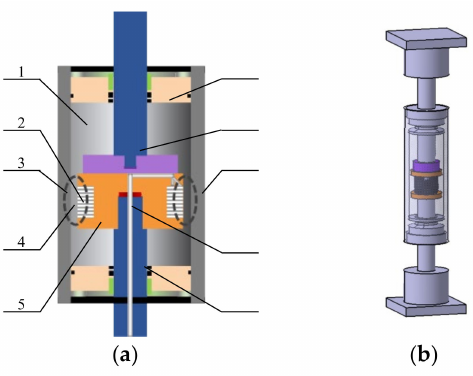
Figure 11. A mixed type of flow shear linear MRD: ( a ) structure diagram; ( b ) prototype.